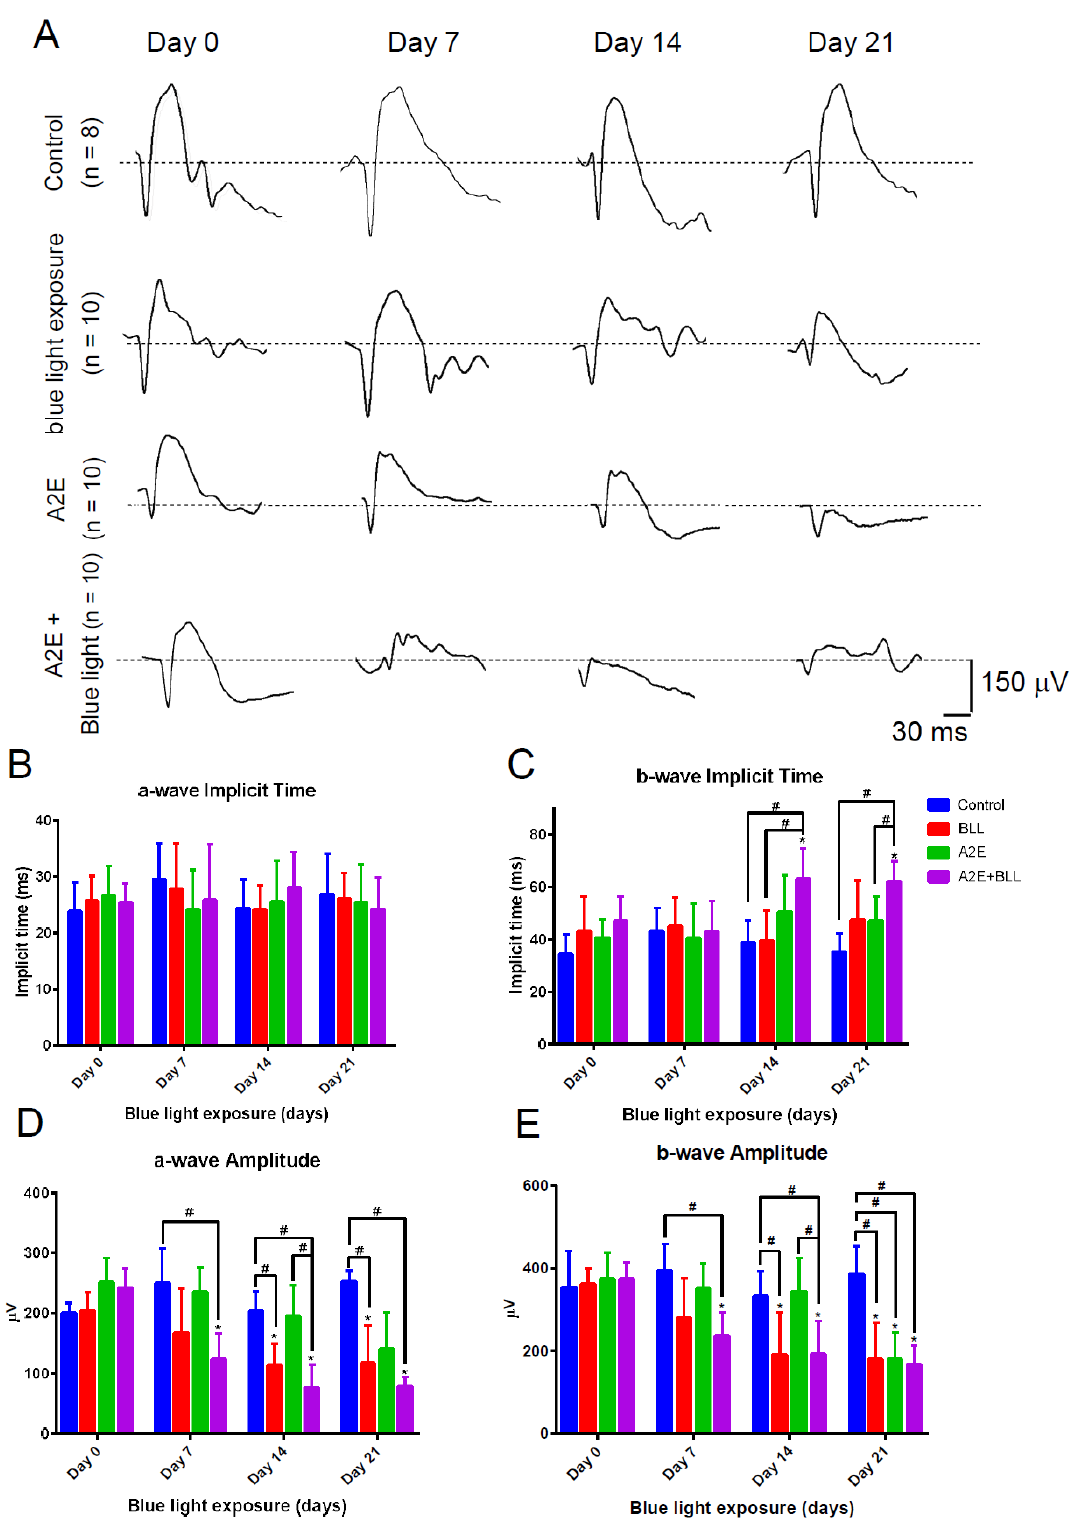
Figure 7. Blue light reduces retinal neuron transduction in A2E-treated Brown Norway (BN) rats. ( A ) Representative electroretinography (ERG) a- and b-waves of the control group (N = 8), BLL group (N = 10), A2E group (N = 10), and A2E + BLL group (N = 10). ( B – E ) ERG data were measured on day 0, day 7, day 14, and day 21 for the four groups, and the a- and b-wave amplitude ( µ V) and implicit time (ms) of the ERG waveforms were analyzed. * p < 0.05 was considered statistically significant compared to day 0. # p < 0.05 was considered statistically significant between groups in the same day.